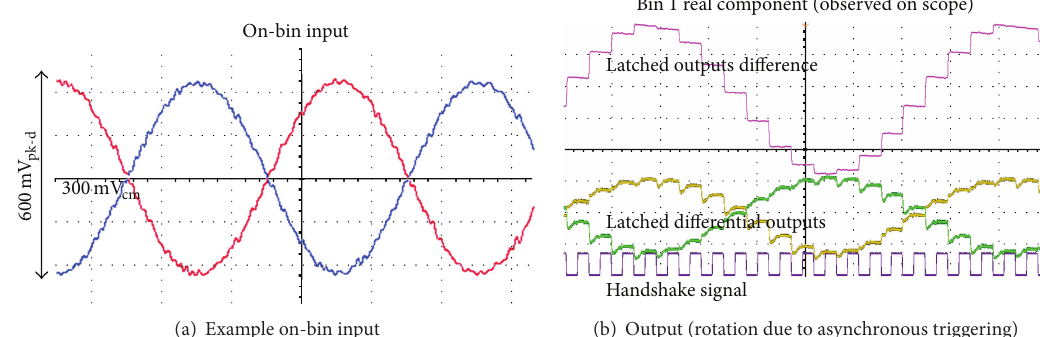
Figure 20: Time-domain latched CRAFT outputs and single-bin input, with fractional triggering rate for periodic phase rotation of output.